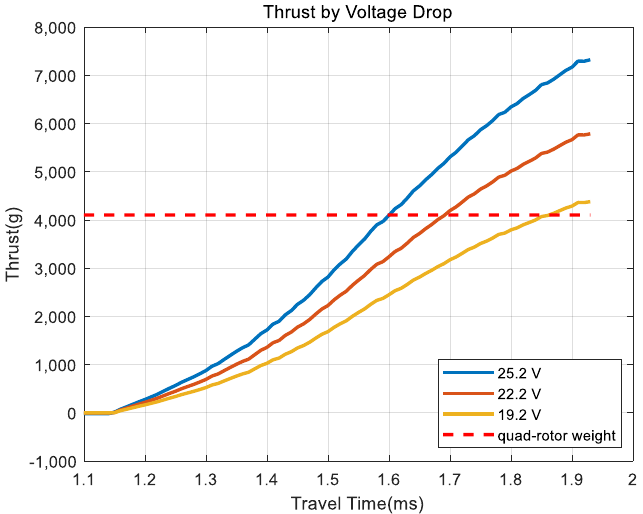
Figure 18. Change of thrust by voltage drop at same control